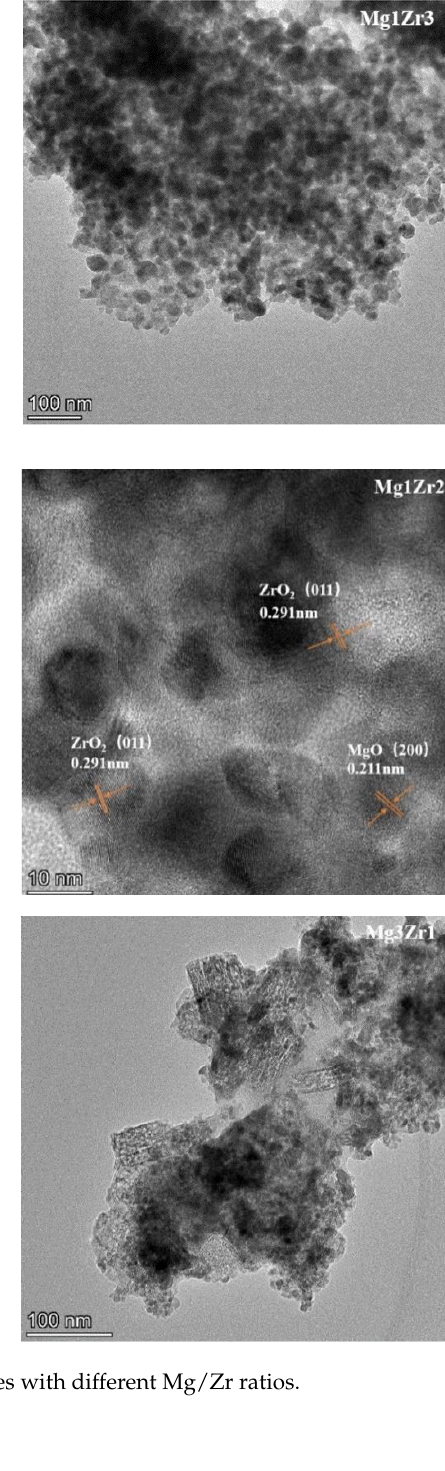
Figure 3. TEM images of Mg-Zr composite oxides with different Mg/Zr ratios. The N 2 adsorption-desorption isotherms of Mg-Zr composite oxide catalysts are shown in Figure 4. There are obvious type IV adsorption equilibrium isotherms in the range of P/P 0 = 0.5~1.0, indicating that the catalysts had mesoporous structures. ZrO 2 , Mg1Zr3, Mg1Zr2, and Mg1Zr1 catalysts all have H2 type hysteresis loops, indicating that the catalyst internal pore structure is ink bottle; The N 2 adsorption-desorption isotherms of Mg2Zr1, Mg3Zr1, and MgO catalysts have no obvious saturated adsorption platform, accompanied by H3 hysteresis loop, indicating that the pore structure of the catalyst is very irregular, combined with the TEM results, it can be seen that there is the slit hole formed by the accumulation of flake particles. 0